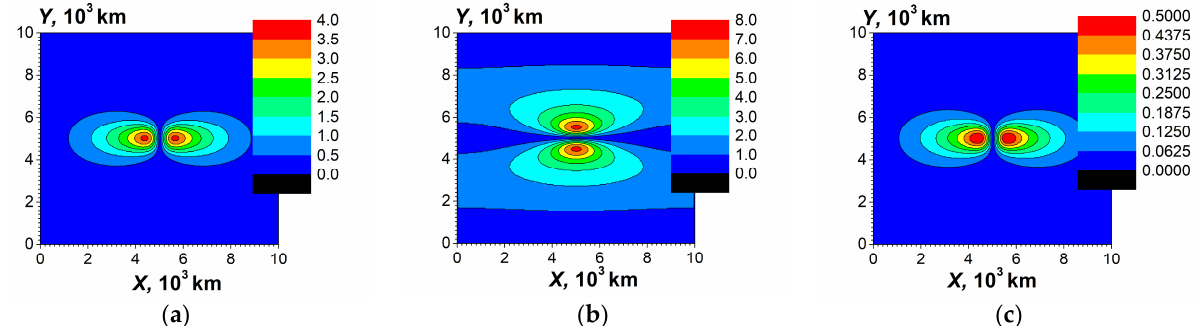
Figure 10. Distributions of the electric field components (in mV/m) in the ionosphere F -layer at the height z = 200 km. The quasi-electrostatic simulations, the case of closed geomagnetic field lines. The frequency is ω = 0.025 s − 1 . Part ( a ) is |E x (x,y)| , ( b ) is |E y (x,y)| , ( c ) is |E z (x,y)| . The inclination angle of the geomagnetic field is θ i = 10°. The total vertical distance of the simulation is L z = 2000 km.